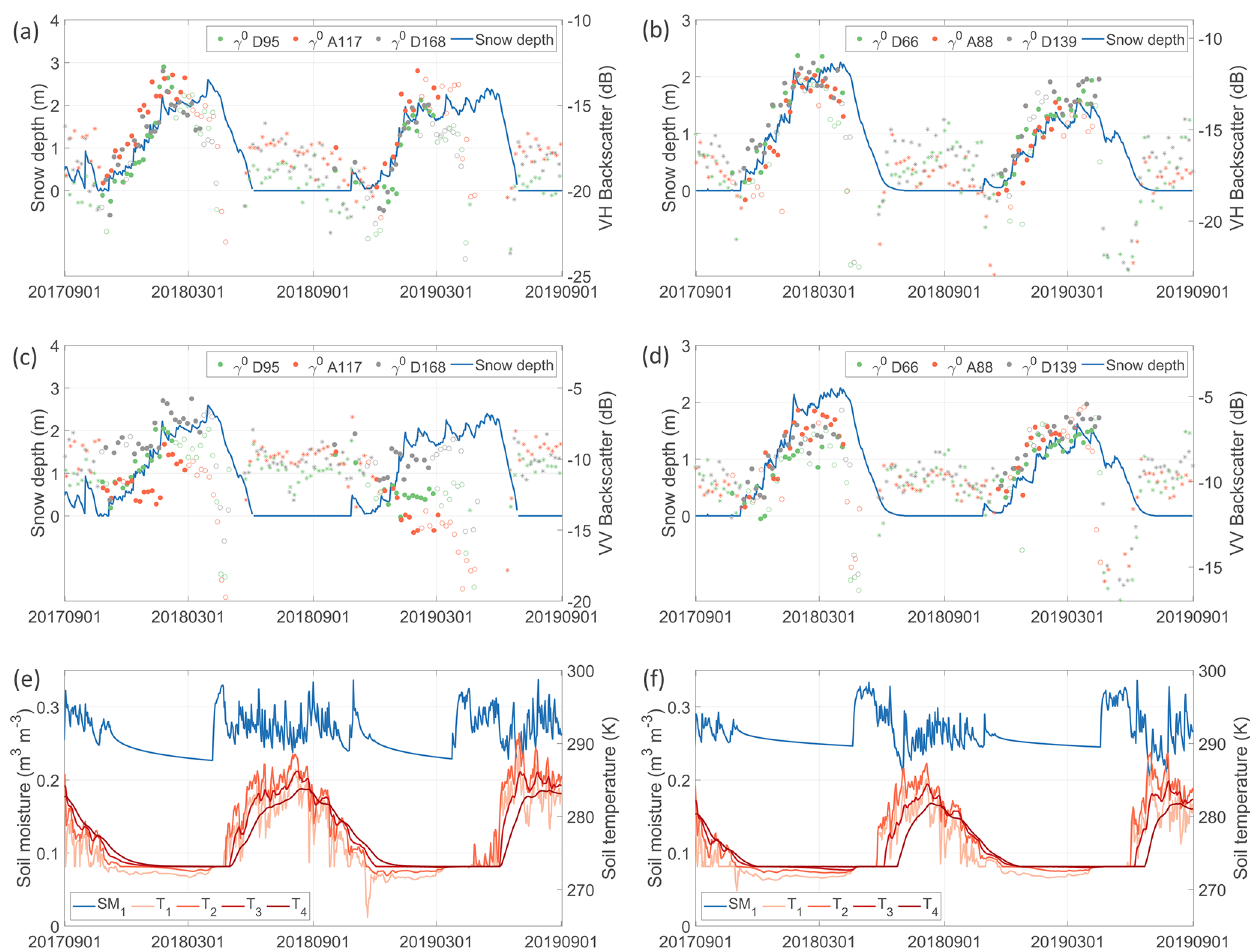
Figure 3. Time series of S1 γ 0 (dB) for three different orbits, in (a, b) VH polarization and (c, d) VV polarization, compared against model simulations of snow depth (m) for a grid cell in (a, c) Austria and (b, d) Switzerland. The γ 0 observations during snow-free conditions (based on IMS SC) are displayed by ∗ and those during wet snow conditions (based on S1) by open circles. The γ 0 axes are scaled to enhance visualization. Panels (e) and (f) show corresponding model simulations of soil moisture (SM1: 0–0.1m; in m 3 m − 3 ) and soil temperature (T1: 0–0.1m; T2: 0.1–04m; T3: 0.4–1m; and T4: 1–2m; in kelvin) from the Noah-MP land surface